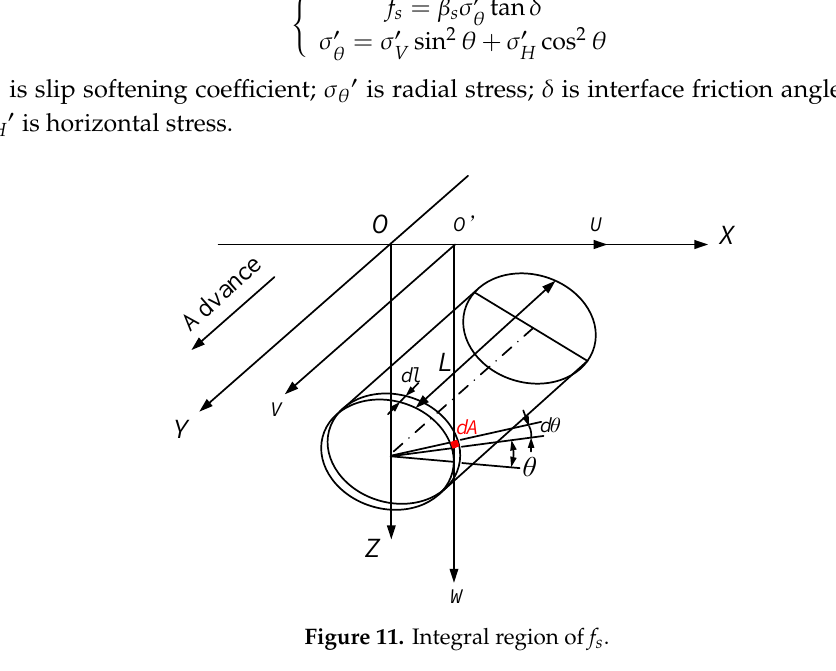
Figure 11. Integral region of f s .